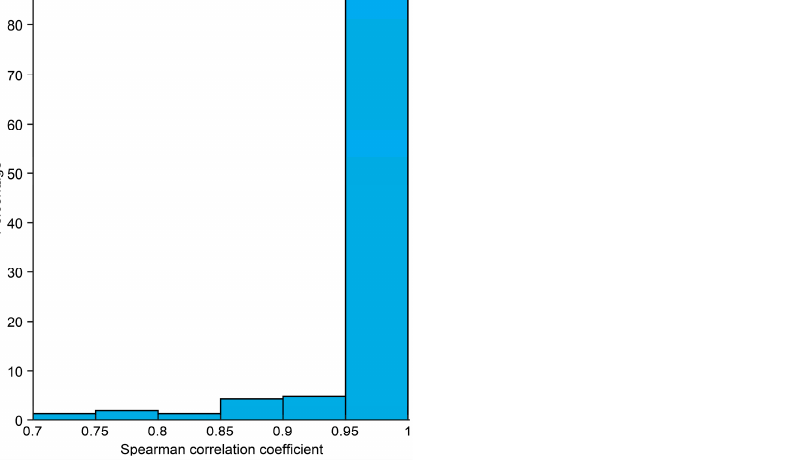
Figure 3. Spearman correlation coefficient distribution histogram of the relTEC change rate solved by dual-frequency carrier phase combination and single-frequency pseudorange carrier phase combination.